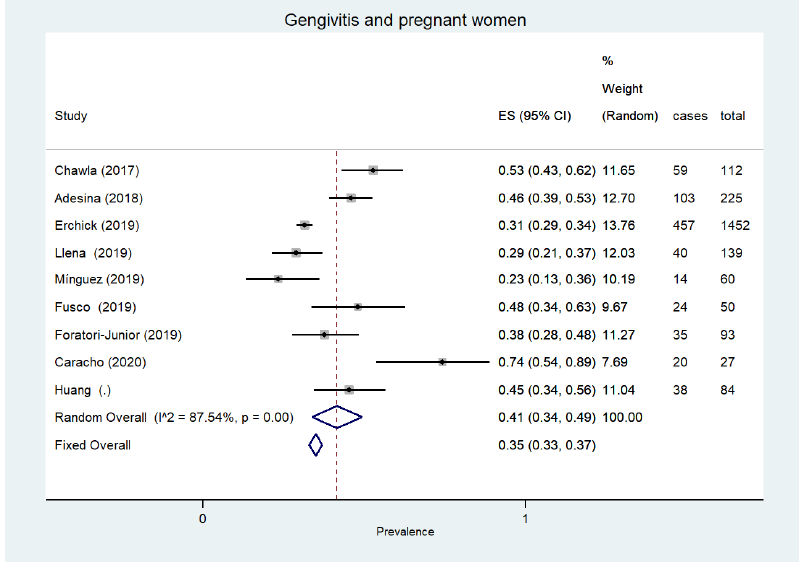
Figure 3. Gingivitis and pregnant women.